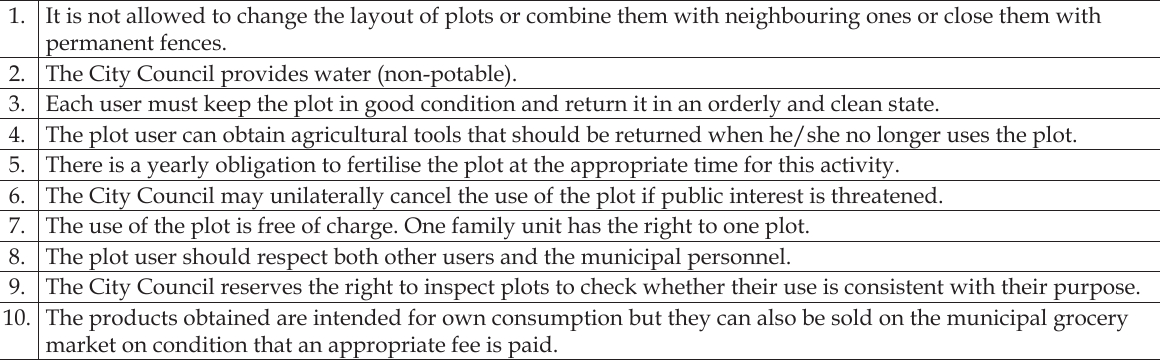
Table 1. Decalogue of mandatory rules regarding the use of allotment gardens in